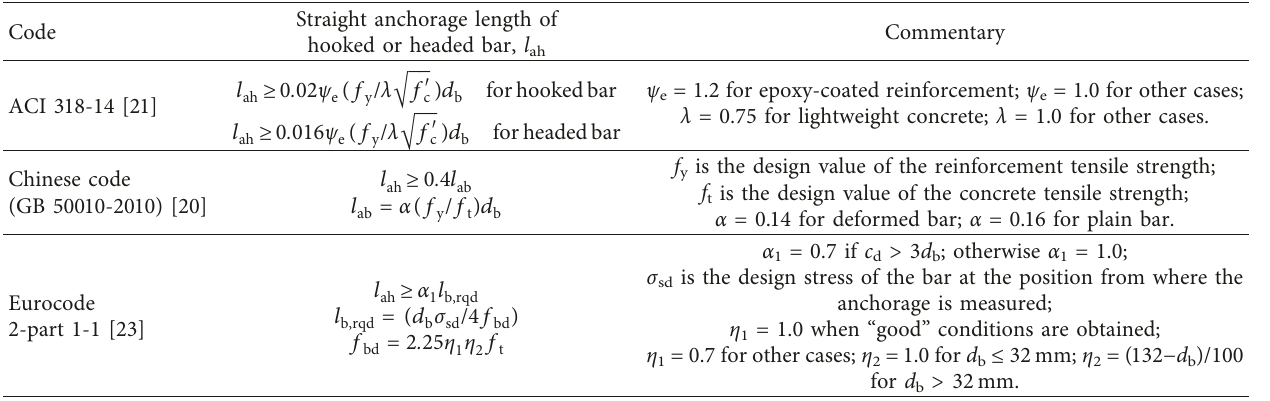
Table 6: Design specifications for straight anchorage length of hooked or headed bar.